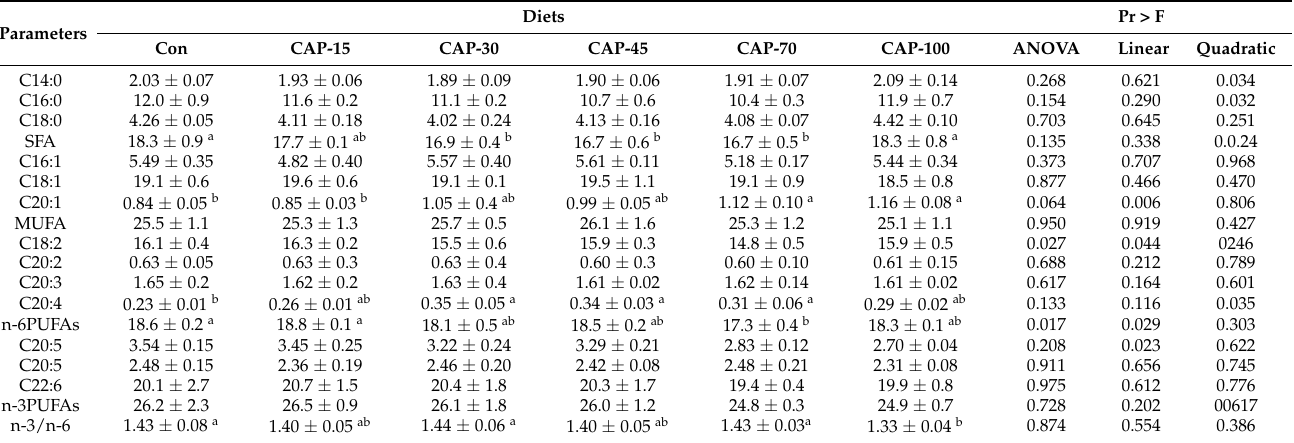
Table 9. Effects of dietary Clostridium autoethanogenum protein on muscle fatty acid composition of largemouth bass (percentage of fatty acids, %).